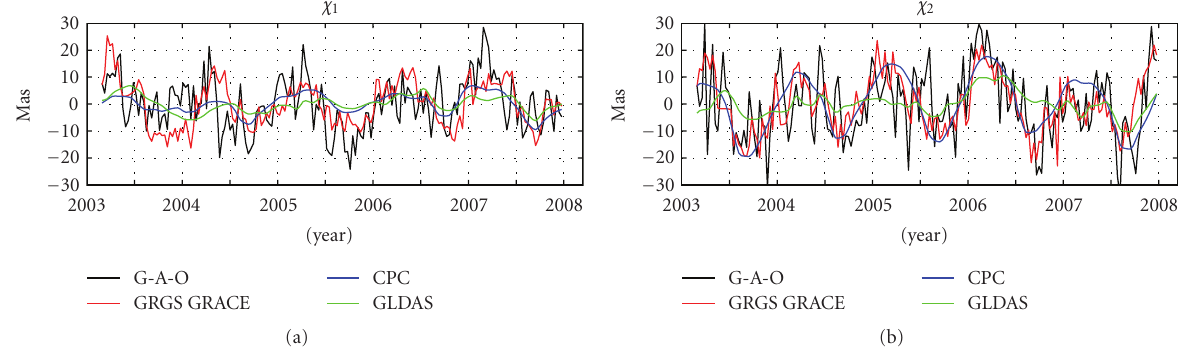
Figure 2: Hydrological excitation functions computed from geodetic residuals (G-A-O), GRACE solutions, and CPC and GLDAS hydrological models. We observe that GRACE-based excitations are well correlated with geodetic residual. We note the large di ff erences between the hydrological models especially in the case of χ 2